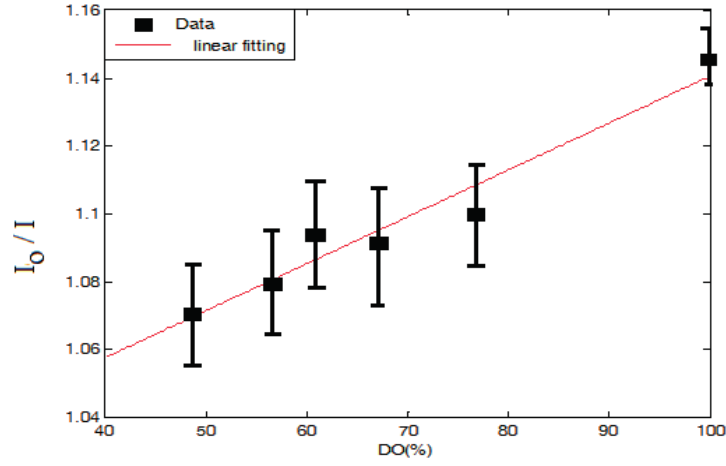
Figure 7. Relative peak intensity change with DO